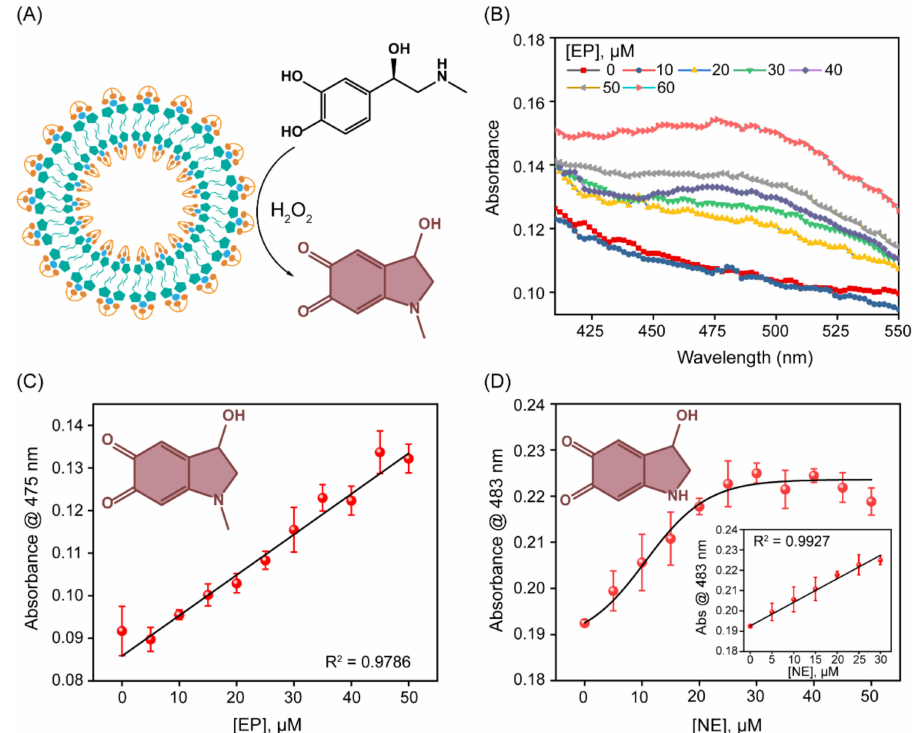
Figure 4. SupraZyme catalyzed oxidation of EP and NE. ( A ) Graphical representation of EP oxidation to adrenochrome using SupraZyme, ( B ) UV-Vis absorbance spectra obtained by oxidation of EP (0 to 60 µ M) in the presence of SupraZyme at H 2 O 2 = 1 mM ( C ) Absorbance at 475 nm as a function of EP concentration varying from 0 to 50 µ M at H 2 O 2 = 1 mM. The black line represents a linear fitting of the data giving a detection limit of 6.3 µ M while the brown colored product is the oxidized product adrenochrome, ( D ) Plot of absorbance at 483 nm as a function of NE concentrations varying from 0 to 50 µ M at 1 mM H 2 O 2 where the oxidized product noradrenochrome is presented in brown color. The black line represents the dose-responsive curve fitting for guiding the eye and the inset shows the linear fitting of the data and corresponding limit of detection for NE is 1.8 µ